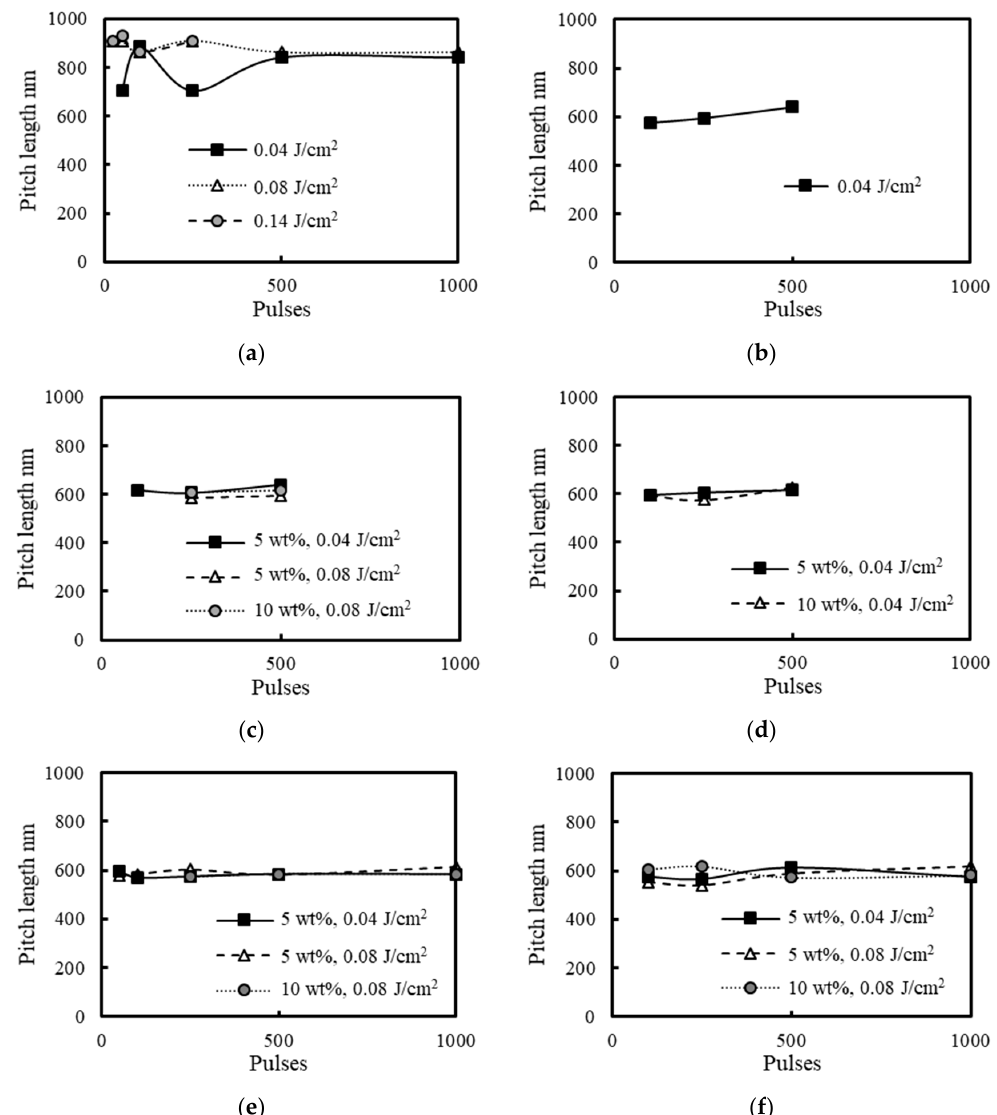
Figure 8. Relationship between the periodicity of laser-induced periodic surface structures (LIPSSs) and laser irradiation conditions under ( a ) air, ( b ) water, ( c ) 5 and 10 wt% NaCl solutions, ( d ) 5 and 10 wt% NaNO 3 solutions, ( e ) 5 and 10 wt% Cu(NO 3 ) 2 solutions and ( f ) 5 and 10 wt% CuSO 4 solutions.